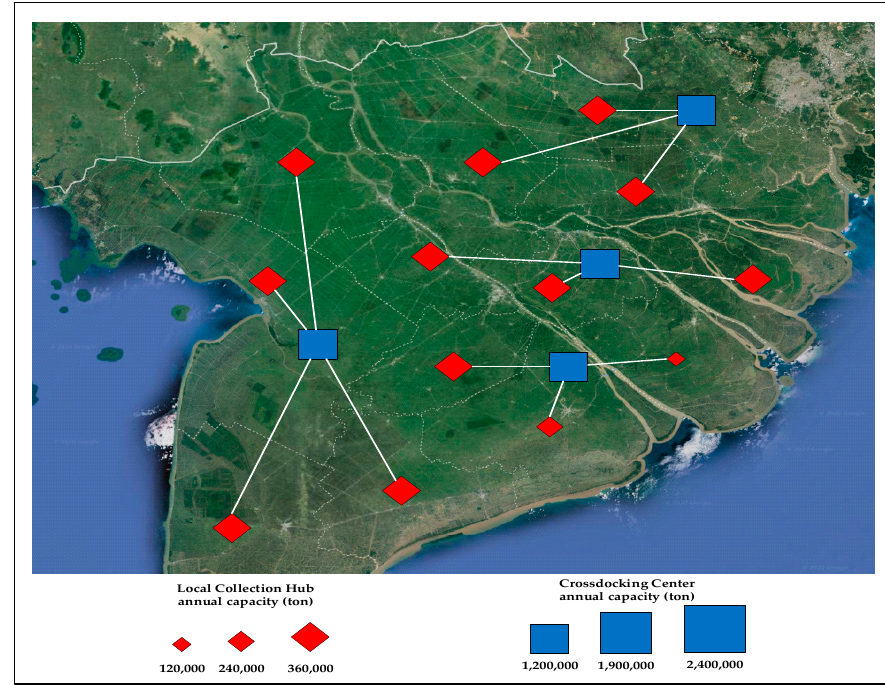
Figure 6. Facility network. Figure 6. Facility